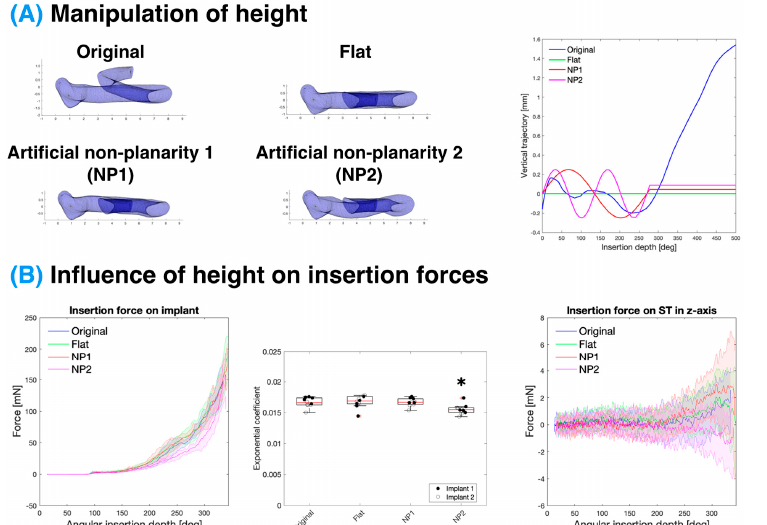
Figure 4. Manipulation of the vertical trajectory of the ST and its influence on CI insertion forces. ( A ) Representation of the 3D geometry ( left ) and the centreline z-component relative to the basal plane ( right ) of the different ST models, only varying in the vertical trajectories of their centrelines; these consist of the original geometry (cut off at 500 ◦ for comparison), a flat model where all centrelines are on the same horizontal plane, and two artificial non-planarities (NP1 and NP2). ( B ) Insertion force on the implant with respect to angular insertion depth ( left ; solid line-mean, shaded area-standard deviation) and respective fitting of the Capstan model exponential coefficient ( middle ; red line-median, box-interquartile range) for models with different vertical trajectories. Data represent n = 10 replicates per condition over N = 2 implants. Only NP2 showed a statistically significant difference ( p values of 0.024, 0.010, and 0.020 compared to “original”, “flat”, and NP1 models, respectively). Vertical forces, along the z -axis, on the ST model due to CI insertion ( right ). Note, altering the vertical trajectory made little difference to the angular insertion depth per mm of length.